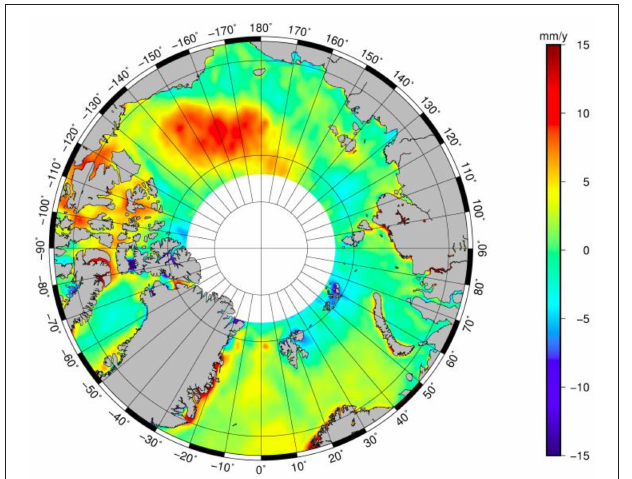
FIGURE 7 | Spatial distribution of linear sea level trend for the period 1993–2015. An increase of 15mm/y is observed in the Beaufort Sea. In the North Atlantic values corresponding to global sea level rise (Nerem et al., 2010) are found.